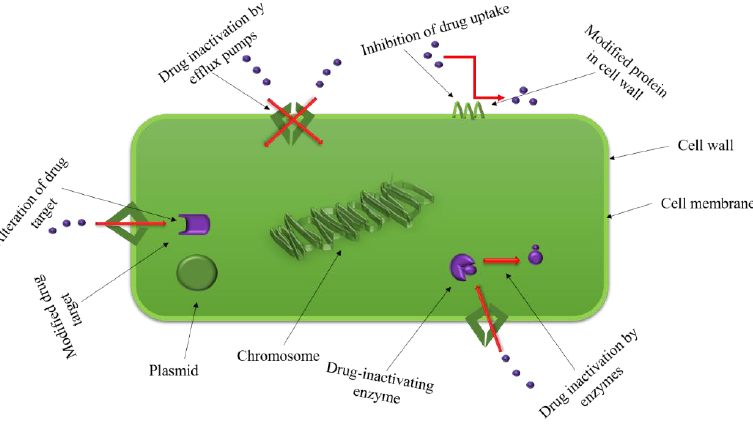
Figure 1. The possible ways a bacterium resists the action of an antibiotic drug.